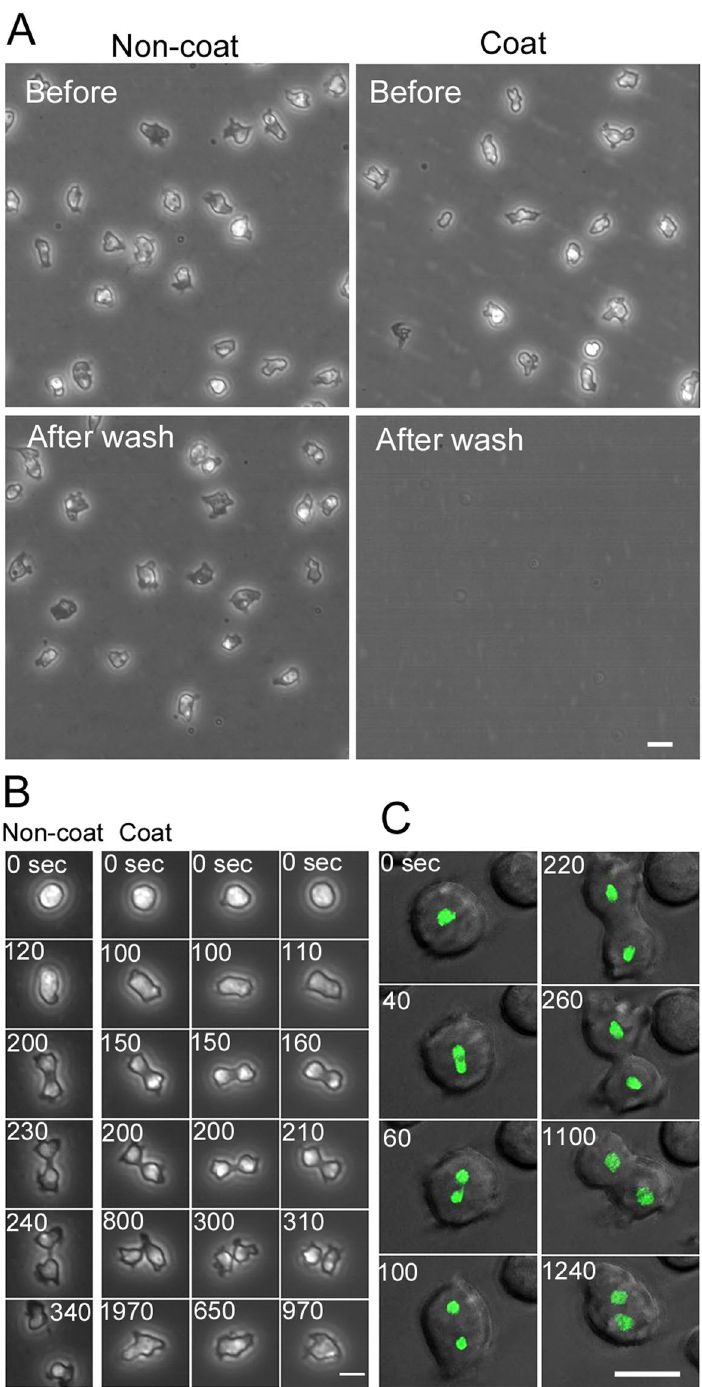
Figure 1. Cells cannot divide without adhering to the substratum. ( A ) When Dictyostelium cells were placed on the coverslip coated with Lipidure, the cells could not adhere to the coverslip and just showed Brownian movement. To demonstrate the detachment of the cells, 20 min after the cells were placed and settled on the coated coverslip, all of the cells were washed off by medium exchange using a fine-tip aspirator. In contrast, most of the cells remained on the non-coated coverslip after the medium was exchanged. The field of view was the same (Before and After wash). ( B ) Typical time courses of cell division on non-coated (left column) and coated coverslips (three right columns) obtained by phase-contrast microscopy. Cells entering the mitotic phase became spherical in shape and subsequently formed the cleavage furrow. However, none of the observed cells could split into two daughter cells under the detached condition (Coat), although the cells on the non-coated substratum successfully underwent cell division (Non-coat). The time of furrow closing was not significantly different between non-coated and coated conditions (161.3 ± 31.9 sec and 165.2 ± 31.0 sec, respectively, n = 55). However, the abscission time (from thread formation to final cutting) was about 60 sec (59.3 ± 18.9 sec, n =